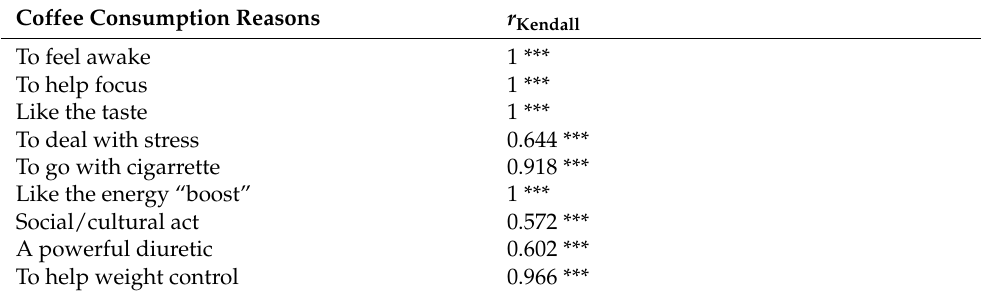
Table 2. Kendall’s correlation coefficients for each coffee-consumption reason appointed in this study, before and during COVID-19